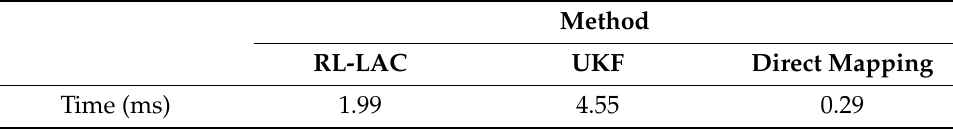
Table 2. Inference times of a single calibration step for different methods.